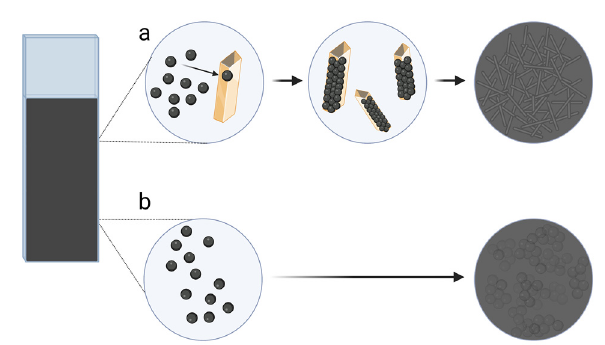
Figure 3. The polymerisation of pyrrole ( a ) in the presence of methyl orange, ( b ) without dyes. ( a ) Electropolymerisation of pyrrole in the presence of methyl orange. Methyl orange creates a rectangular template for attaching pyrrole monomers. This results in the formation of polypyrrole rectangular nanotubes with more surface area. ( b ) Electropolymerisation of pyrrole without dyes, resulting in a polypyrrole with rounder edges and less surface area. All drawings were designed using Biorender.com, accessed on 26 December 2022.